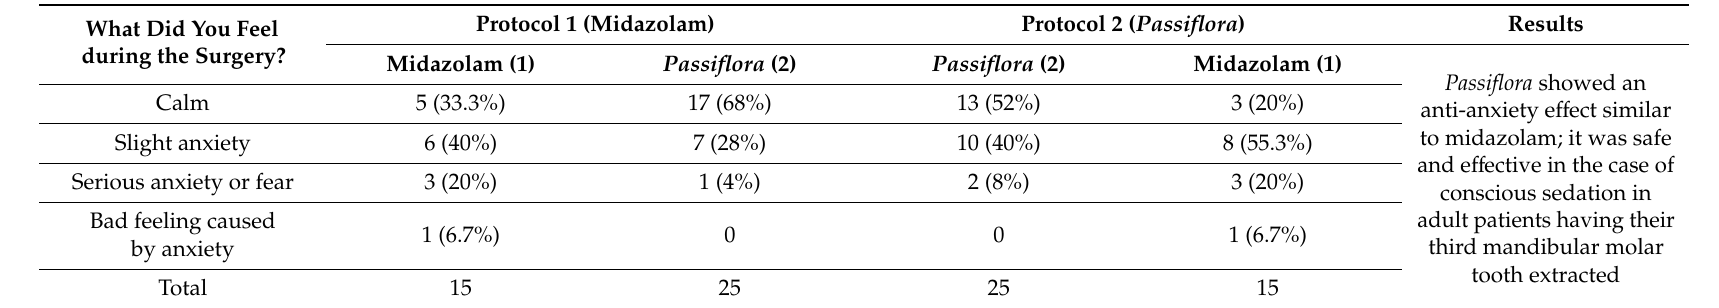
Table 3. Results of the systematic review. The following table refers to the results of the cross-review